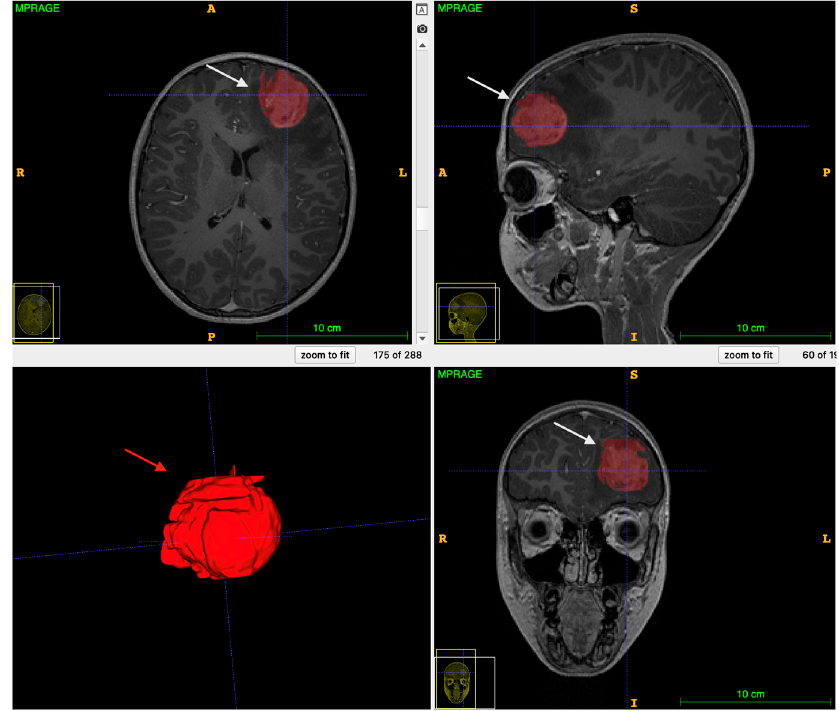
Figure 1. Semi-automatic segmentation and 3D tumor rendering with ITK-SNAP in a 9-year-old boy affected by a left frontal pHGG (grade 4 WHO). The lesion is characterized by a vividly enhanced solid tumor component on post-contrast multiplanar T1-weighted images (white arrows) surrounded by peritumoral edema. The solid tumor component (labeled in red) was segmented semi-automatically with the active contour feature. Semi-automatic segmentation allowed reconstruction of the whole tumor volume (red arrow).